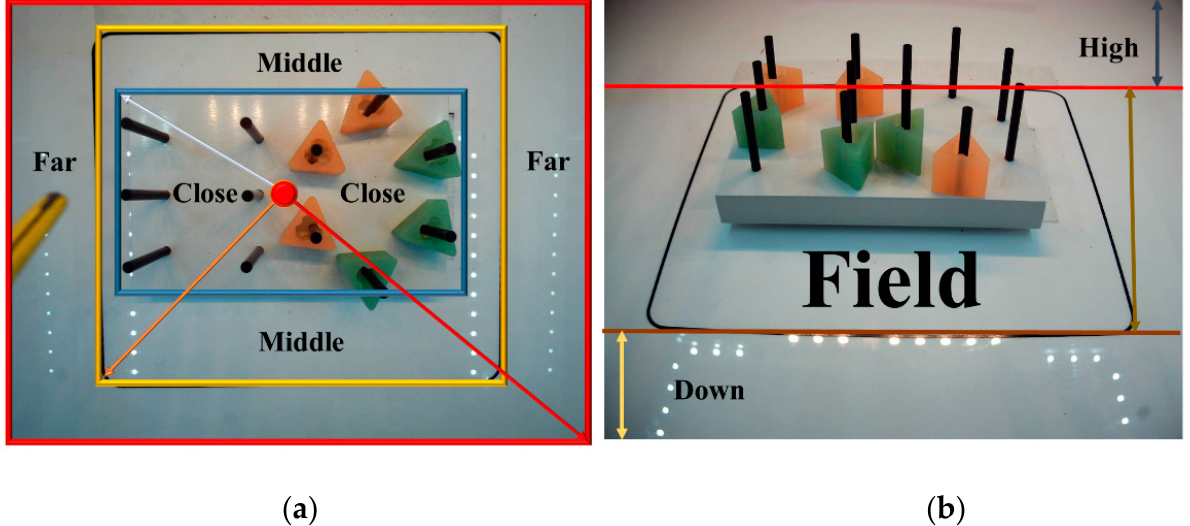
Figure 2. Top ( a ) and front ( b ) view segmentation for the purpose of three-dimensional assess- ment.